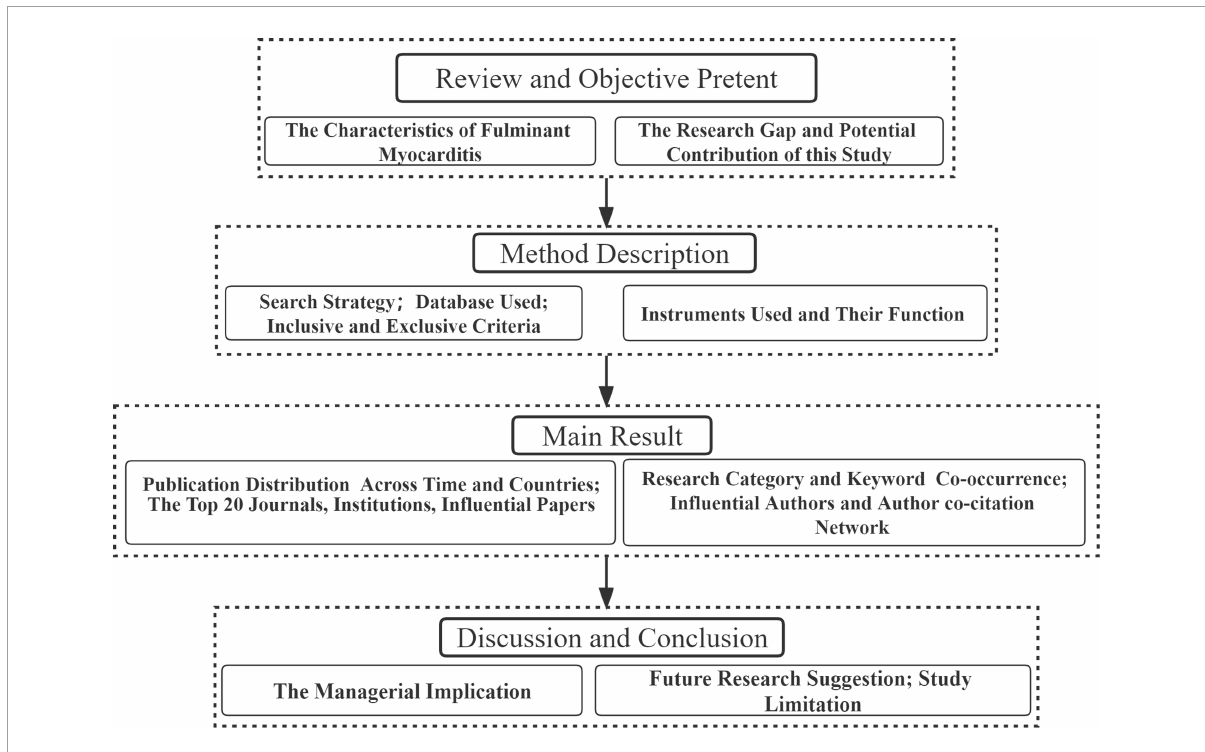
FIGURE1 Flowchart of the